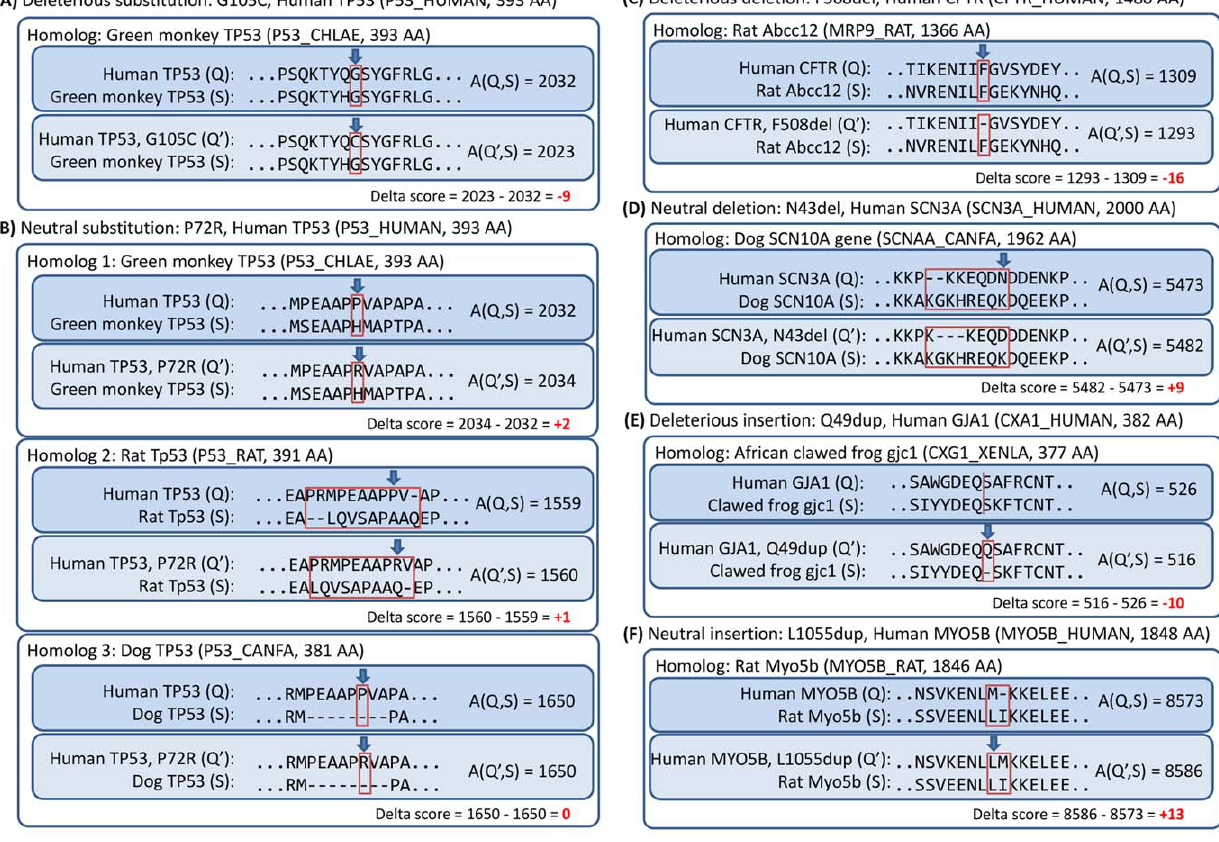
Figure 1. Examples of computing and interpreting delta alignment scores for six different known variations, (A) deleterious substitution (MIM:151623), (B) neutral substitution (dbSNP:rs1042522), (C) deleterious deletion (MIM:219700), (D) neutral deletion (dbSNP:rs72471101), (E) deleterious insertion (MIM:164200), and (F) neutral insertion (dbSNP:rs10625857) with respect to the selected homologous proteins. The amino acid residue replaced, deleted, or inserted is indicated by an arrow, and the difference between two alignments is indicated by a rectangle. Low delta scores are interpreted as deleterious, and high delta scores are interpreted as neutral. The BLOSUM62 and gap penalties of 10 for opening and 1 for extension were used.